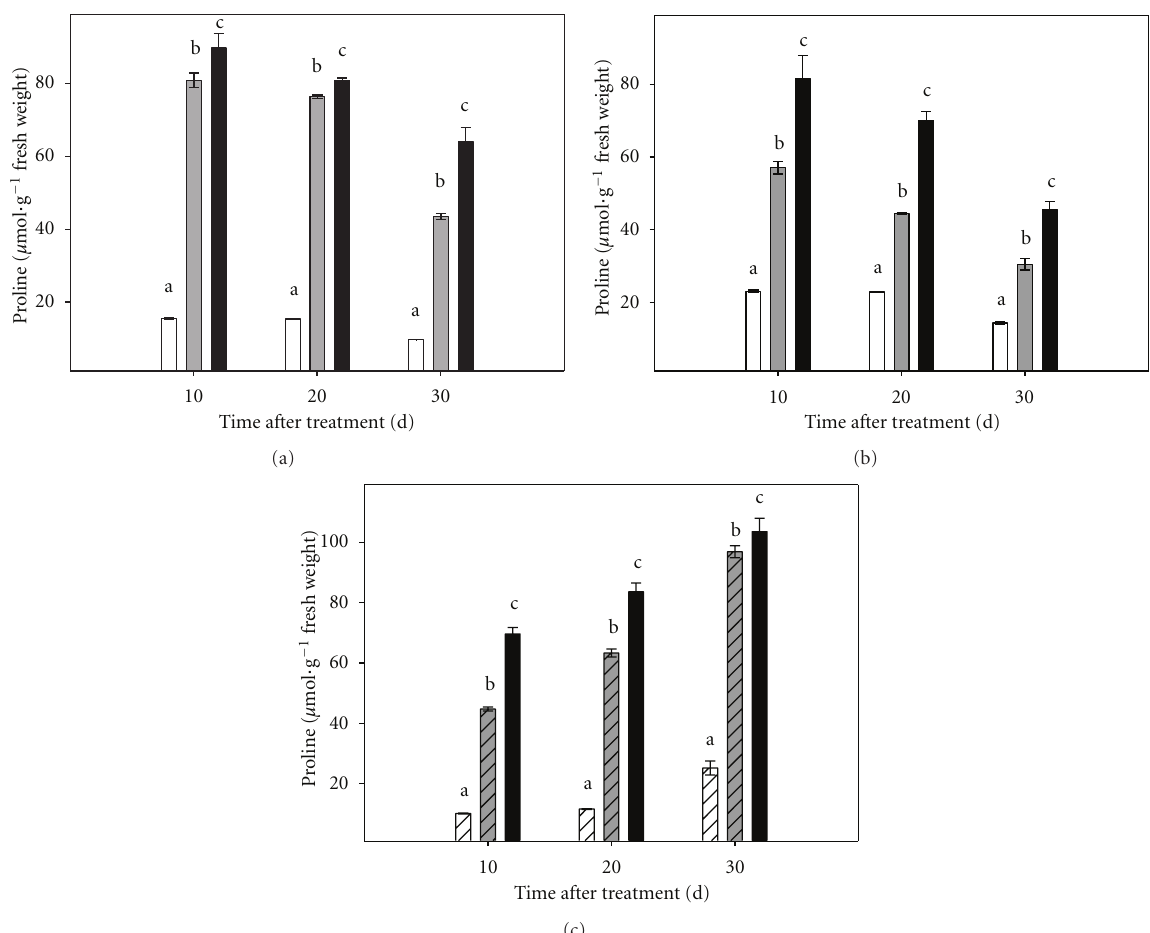
Figure 7: E ff ect of osmotic stress on proline content in Carrizo citrange plants cultured in vitro . (a): aerial part of intact plants; (b): root tissue of intact plants; (c): micropropagated shoots. Control plants (white bar), plants cultured under moderate (grey bar) or severe (black bar) osmotic stress conditions. Each point corresponds to the average ± standard error of six independent determinations. Di ff erent letters denote statistical significance at P <